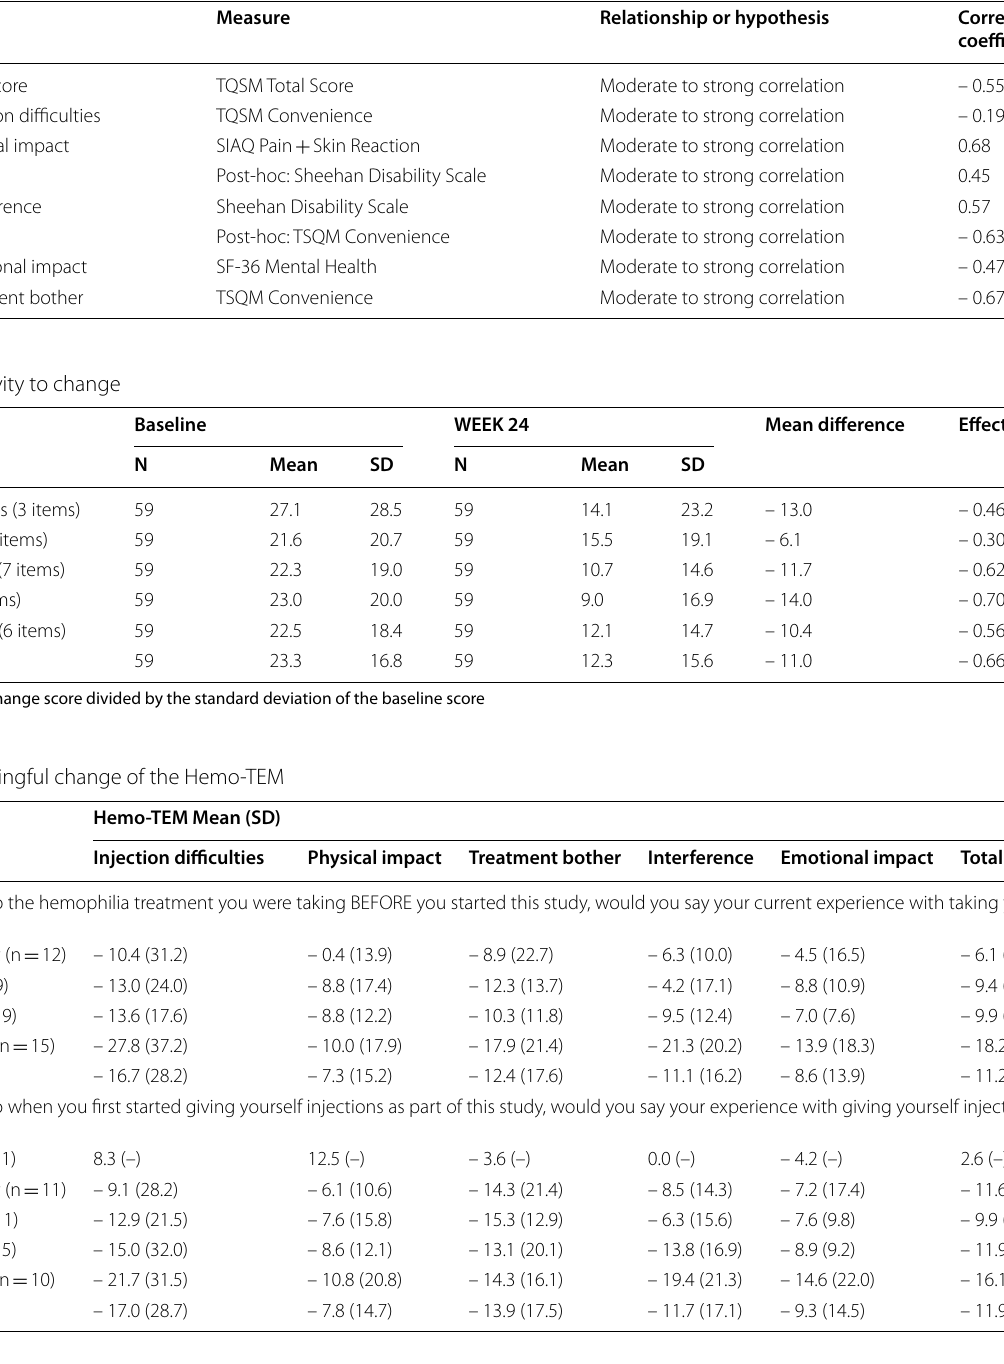
Table 8 Evidence for convergent validity of the